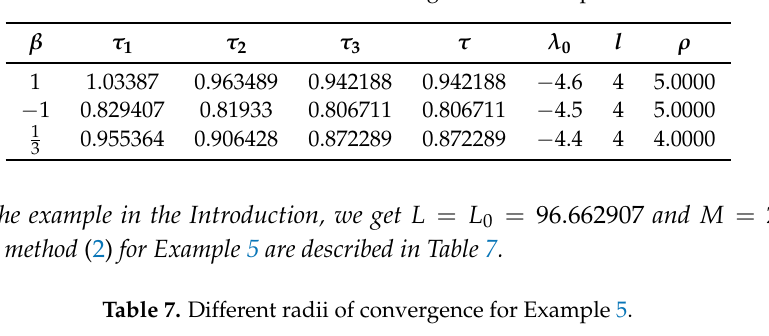
Table 6. Different radii of convergence for Example 4.